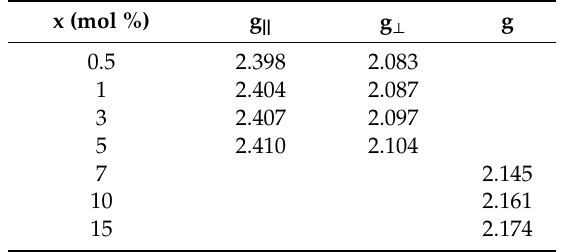
Table 1. The g , g || and g ⊥ factors values for the CuNPsPSbSm